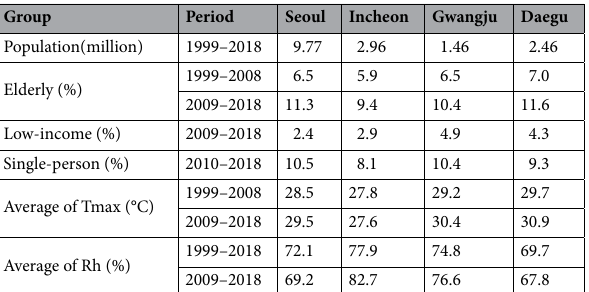
Table 1. The population and climate of summer (JJA) in study cities. *Tmax: maximum temperature; Rh: relative humidity. **Source of data: Statistics Korea 32 .